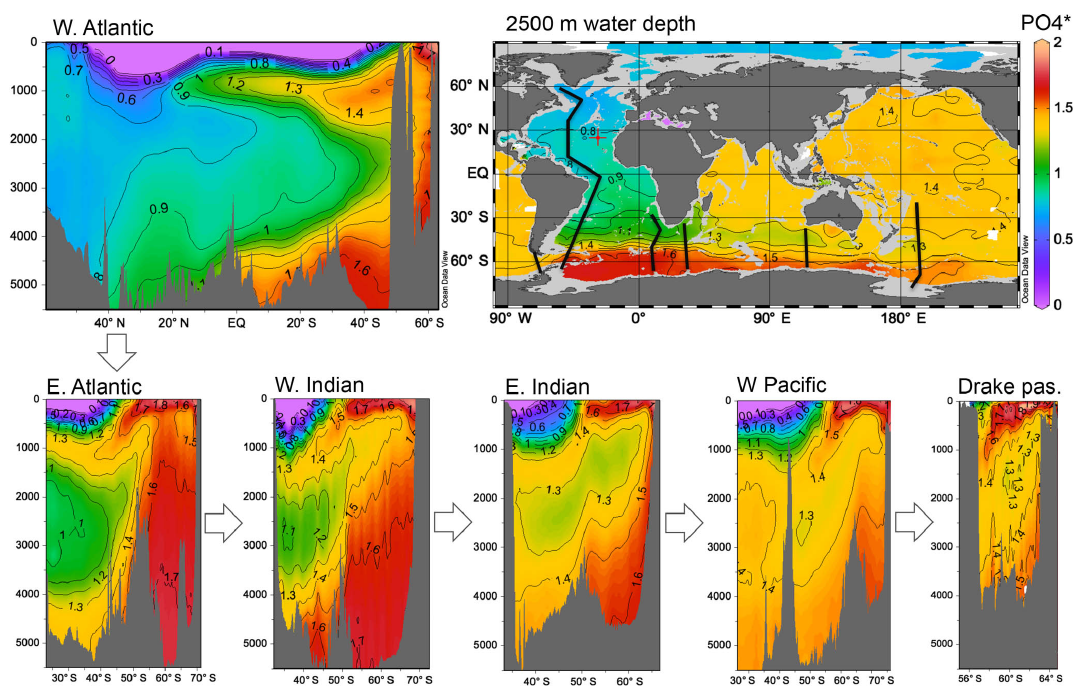
Figure 6. PO ∗ sections for the western Atlantic and for a series of quadrants of the Southern Ocean. Low-PO ∗ 4 Ocean from the Atlantic and the high-PO ∗ waters generated in the Southern Ocean are blended in the Antarctic Circumpolar Current, 4 forming circumpolar deep water. However a PO ∗ high at the seafloor and low at ∼ 2000m continue to trace the influence of AABW and 4 NADW respectively. Data are from GLODAPv2 (Key et al., 2015; Olsen et al., 2016) with profiles, maps, and sections plotted in ODV (Schlitzer, 2015), with sections contoured using isopycnic gridding.